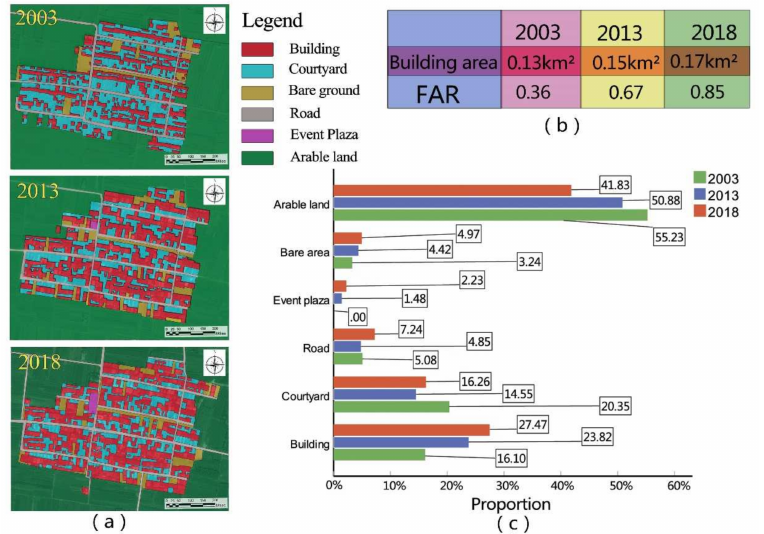
Figure 3. Land use information of the study area. ( a ) The land use maps of the study area in 2003, 2013, and 2018. ( b ) The building area and the floor area ratios (FARs). ( c ) The proportion of different underlying